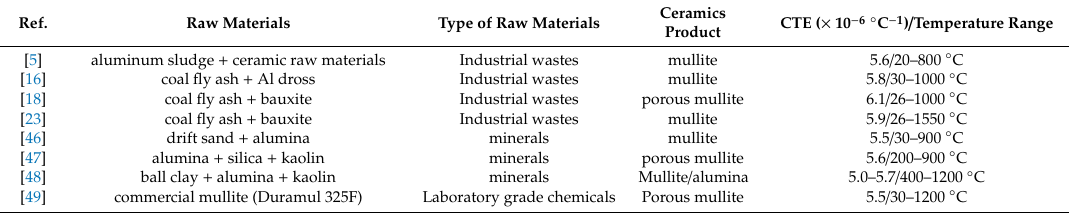
Table 4. Comparison of the coe ffi cient of thermal expansion (CTE) value between the mullite ceramics produced from industrial wastes and from other